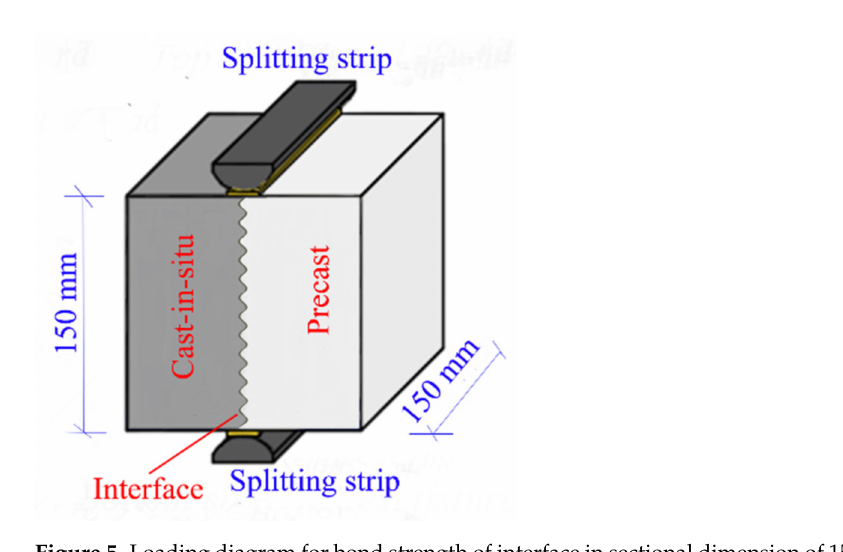
Figure 5. Loading diagram for bond strength of interface in sectional dimension of 150 mm × 150